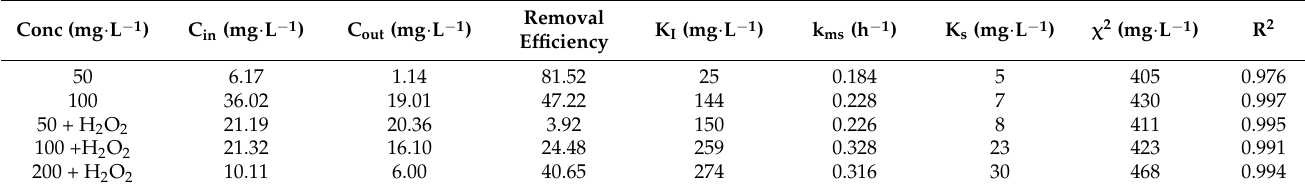
Table 2. Kinetic parameter estimation for the biological reactor at different initial concentrations using measured data (Haldane model).